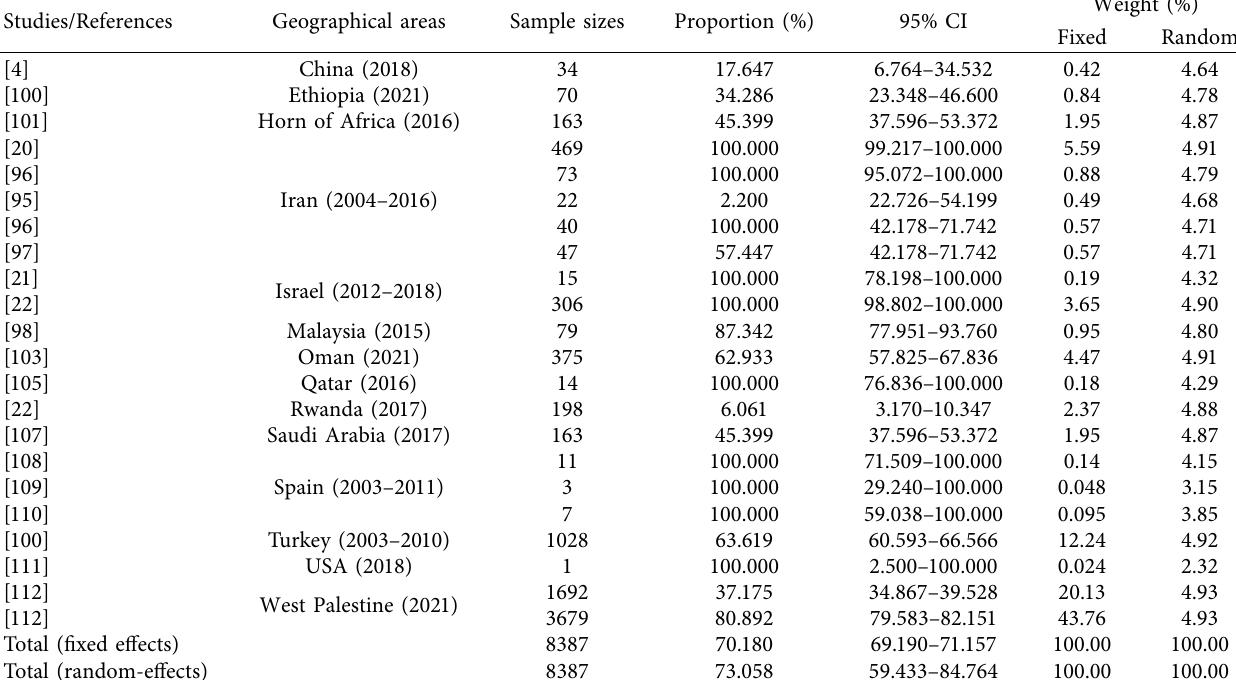
Table 6: Meta-analysis proportion for the prevalence of brucellosis due to the intake of milk and dairy products. Studies/References Geographical areas